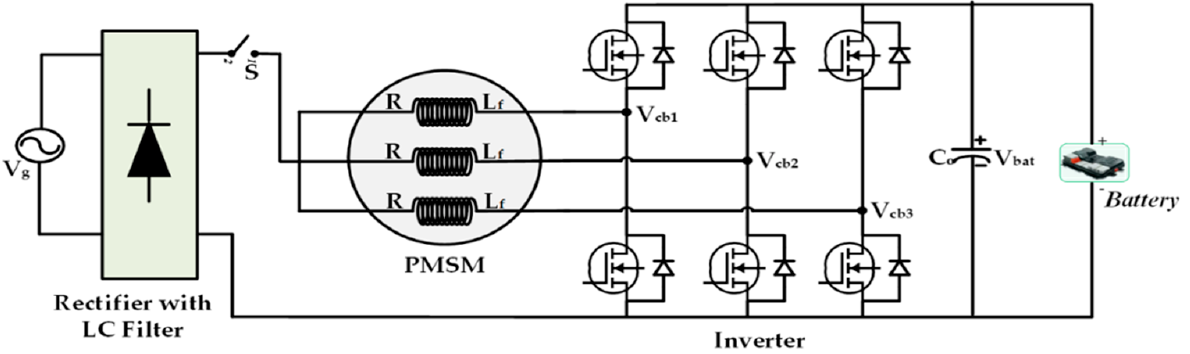
Figure 9. PMSM drive integrated on − board charger with neutral point access proposed by Tuan et al. [67] in 2021 (iOBC5).